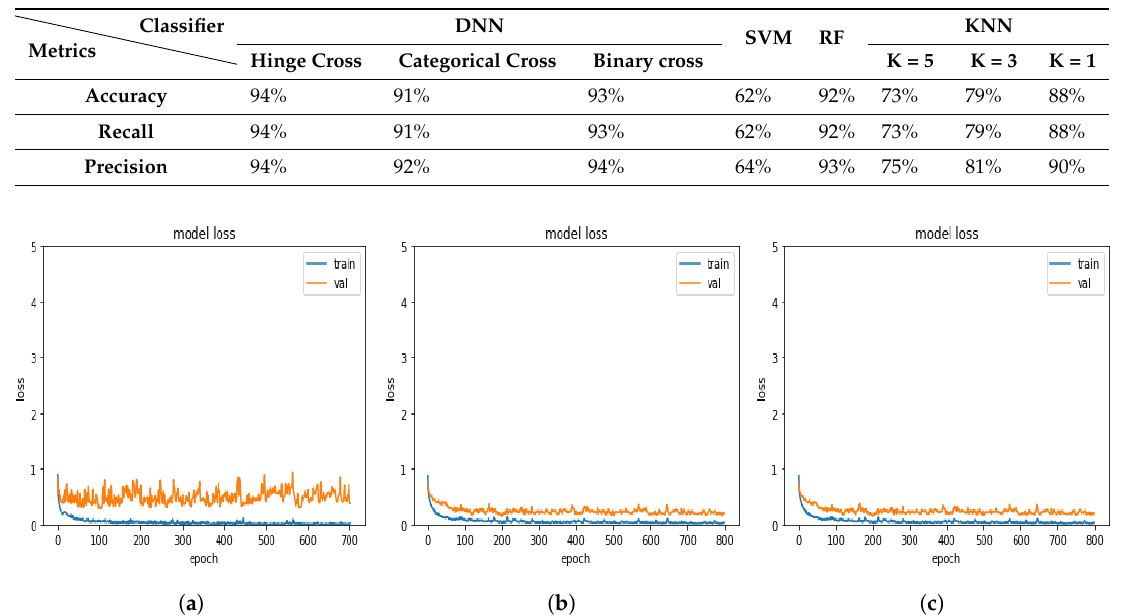
Figure 7. Loss per epoch on the training and validation sets in DNN using different cross-entropy functions: ( a ) categorical cross-entropy (average loss rate = 0.28); ( b ) Binary cross-entropy (average loss rate = 0.24); and ( c ) hinge cross-entropy (average loss rate =